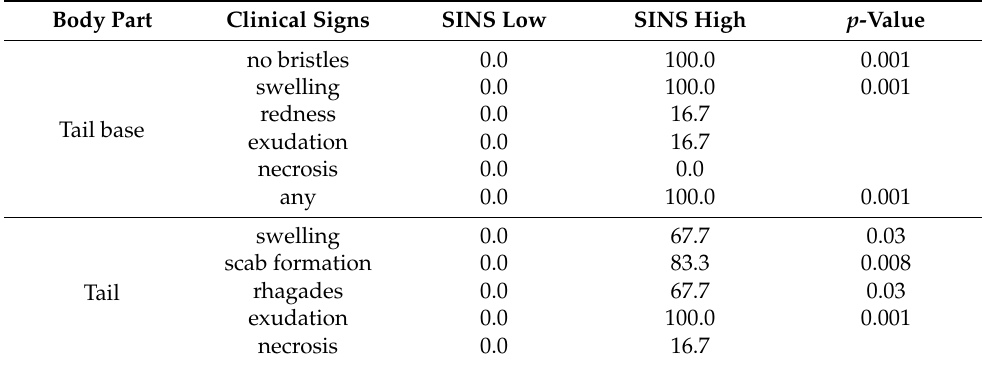
Table 1. Prevalence of clinical signs in different body parts in piglets of the swine inflammation and necrosis syndrome (SINS) low group and the SINS high